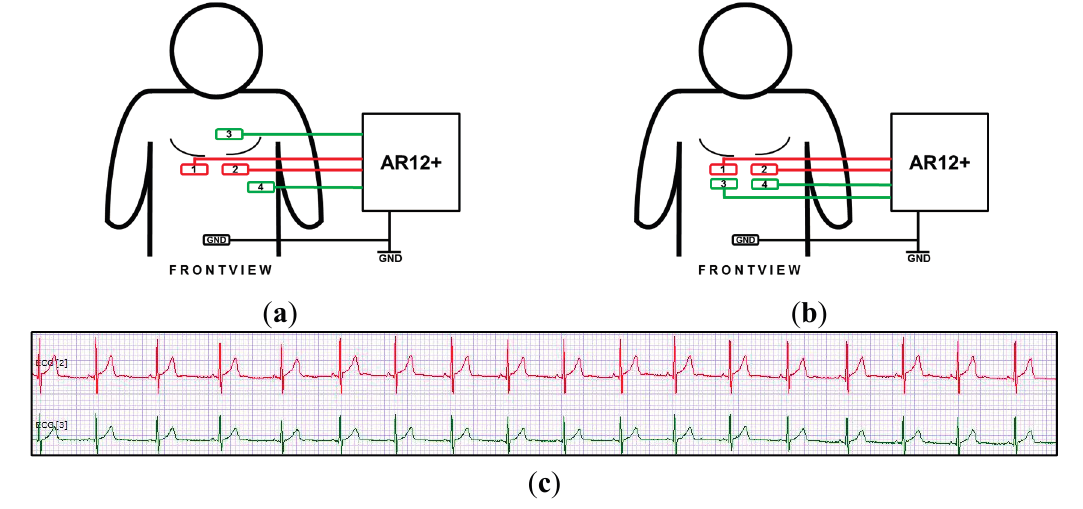
Figure 3. Positioning of the electrodes on the human thorax during our tests. ( a ) Moist textile electrodes placed horizontally within the belt (red #1 and #2); gel electrodes diagonally over the heart, i.e. the classical position for best signals (green #3 and #4); ground centered on the waist; ( b ) Gel electrodes placed as close to the belt as possible; ( c ) Signals obtained with arrangement (b); The test person was at rest with a pulse of